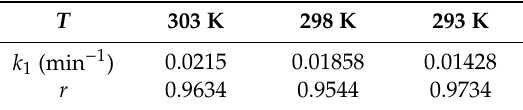
Table 2. Second-order dynamic fitting parameters.